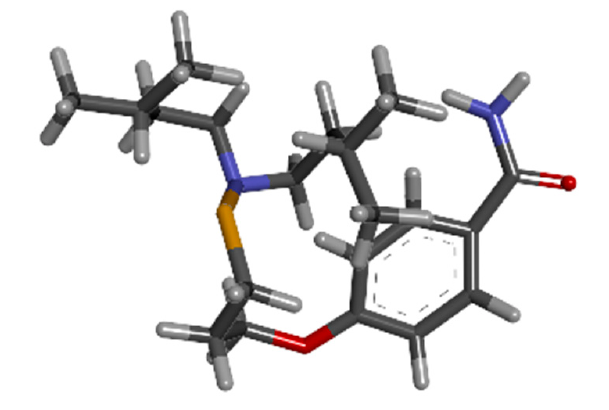
Figure 6. The 3D structure of molecule 1 (AIGT) of Gamma-Tocotrienol AI drug design from WADDAICA.